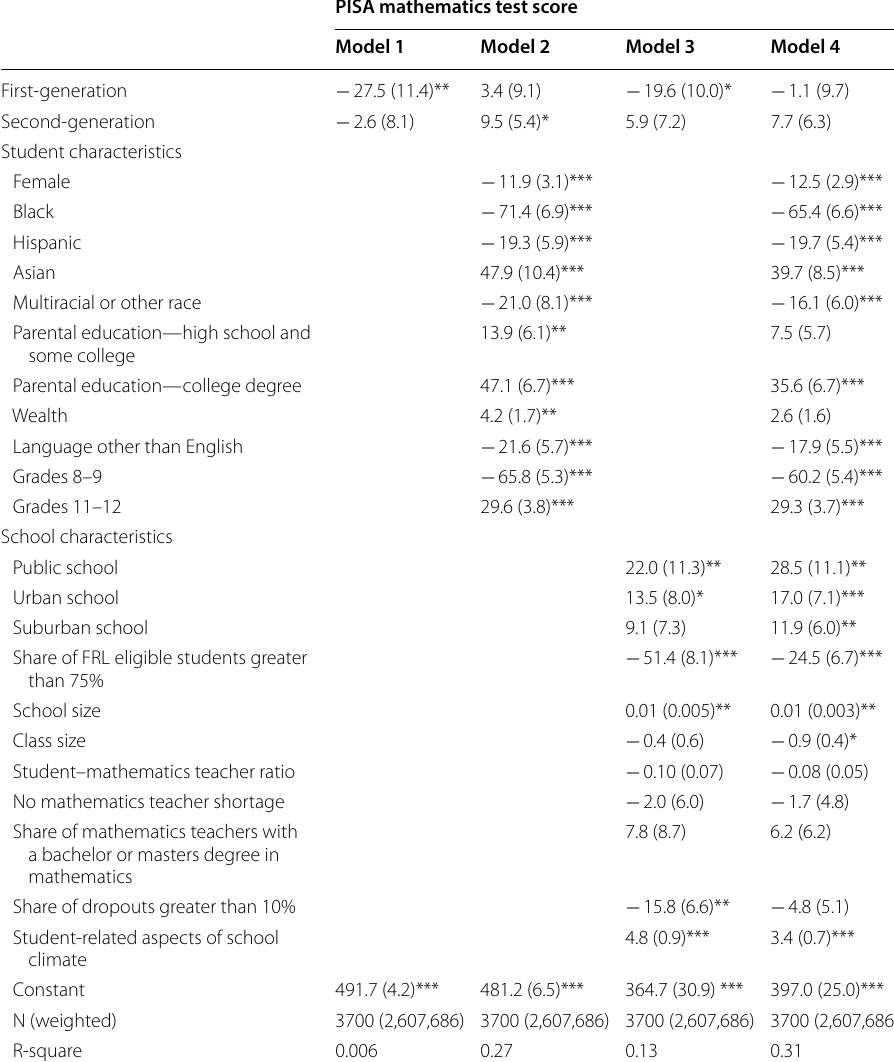
Table 3 Relationship between PISA mathematics score and student and school